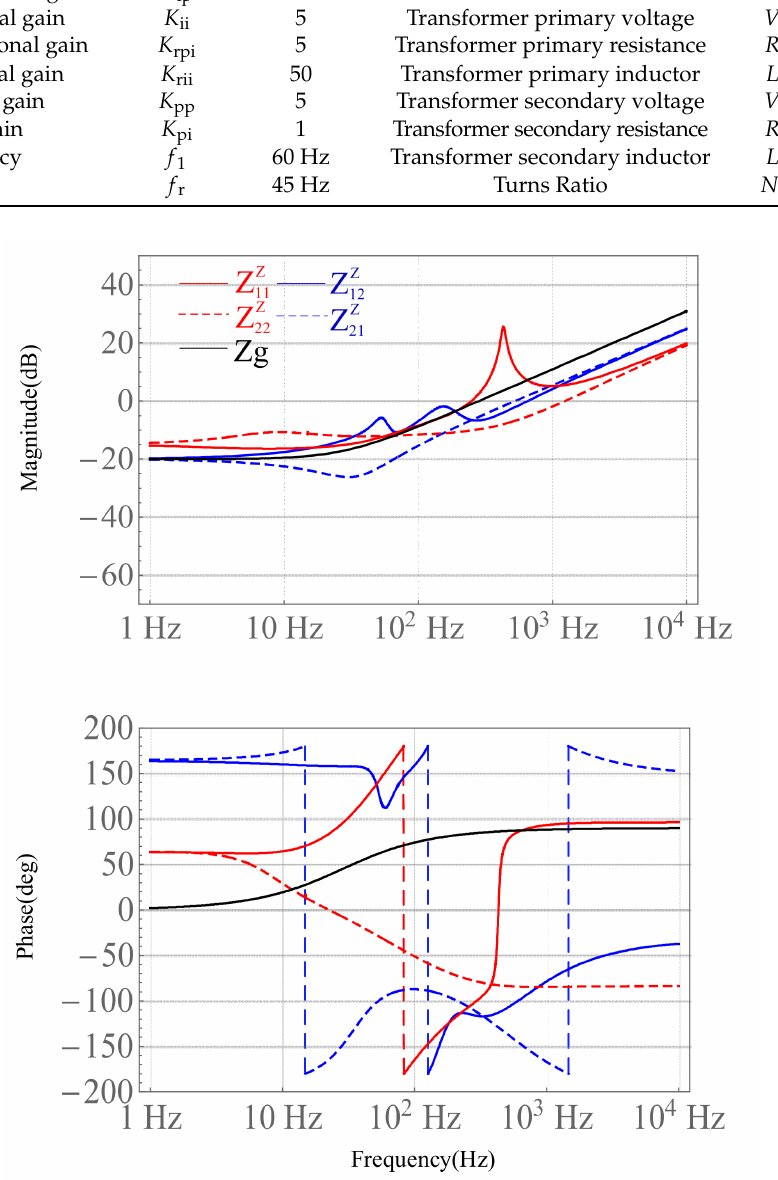
Figure 3. Positive/negative sequence impedance and frequency coupling term ( Z Z entire impedances of the positive and negative sequence perturbation; Z Z coupling terms caused by positive or negative sequence